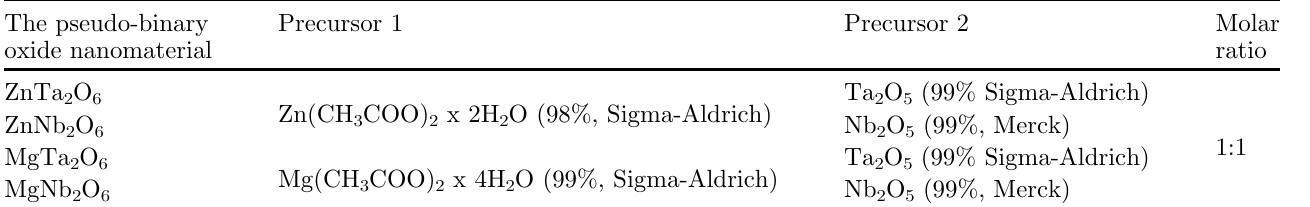
Table 1. The starting materials used to obtain pseudo-binary oxide nanomaterials. The pseudo-binary oxide nanomaterial